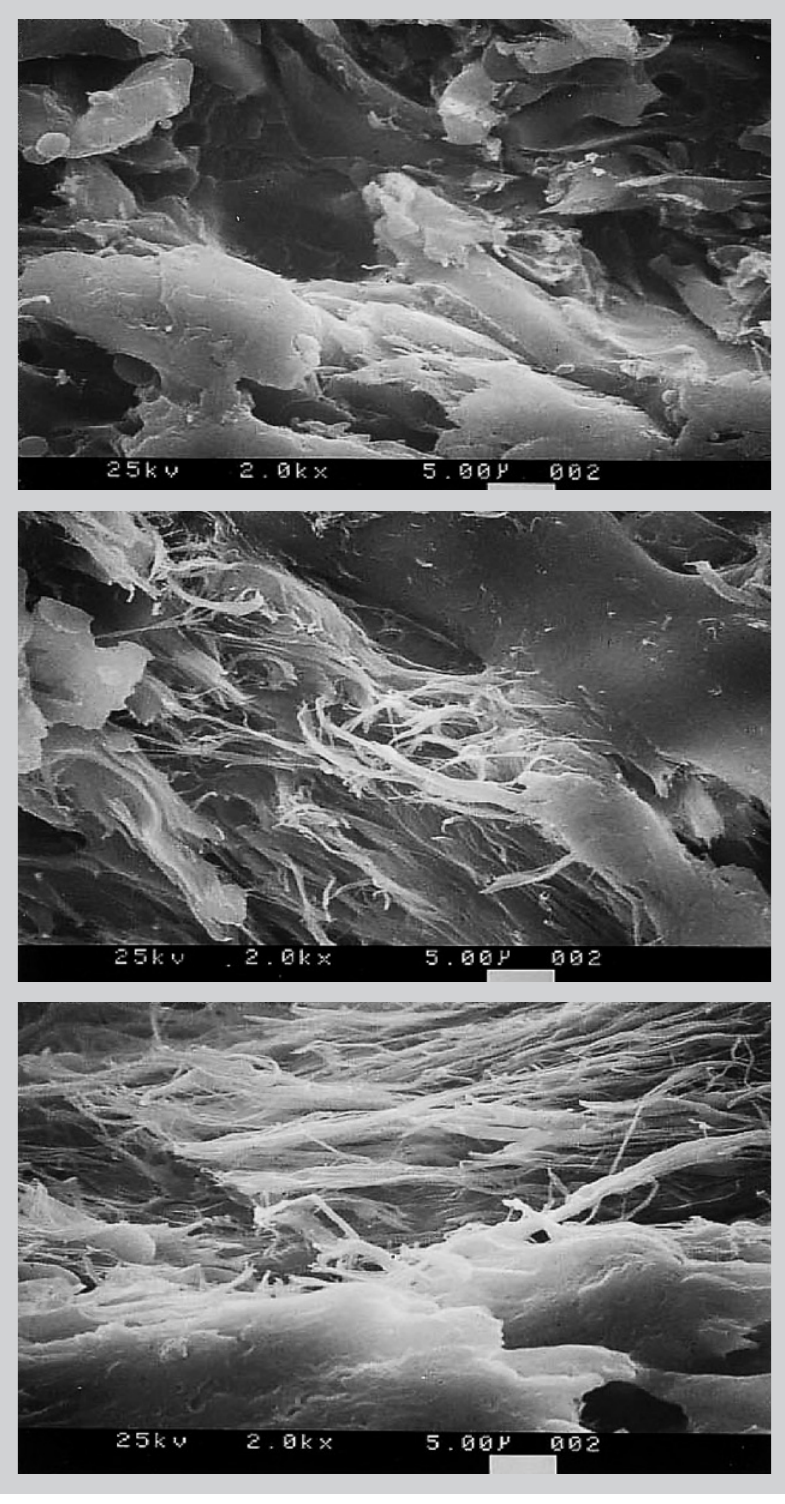
Figure 13 (above): Cryogenic fractured surfaces of LCP/PET:30/70 blend. Figure 14 (middle): Cryogenic fractured surfaces of LCP/PET:50/50 blend. Figure 15 (below): Cryogenic fractured surfaces of LCP/PET:90/10